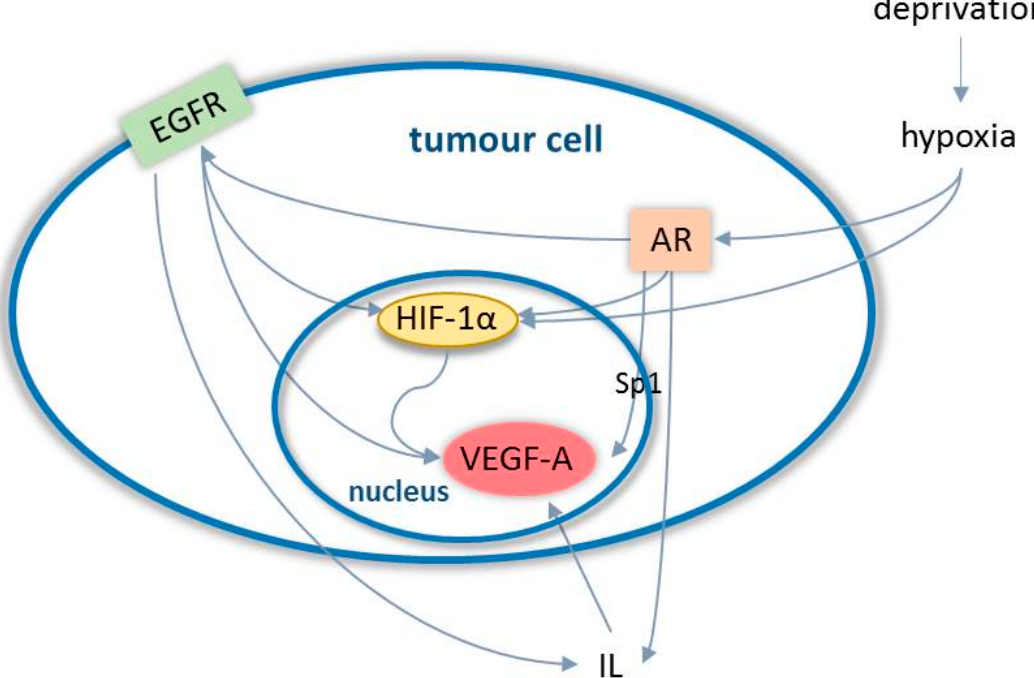
Figure 2. Interaction between angiogenic and androgen receptor pathways in prostate cancer cells. Castration results in androgen depletion which causes hypoxia Hypoxia enhances the transcriptional activity of androgen receptor (AR) at low androgen levels, as seen in castration-resistant prostate cancer. The activated androgen receptor promotes the overexpression of vascular endothelial growth factor A (VEGF-A) through hypoxia-inducable factor 1 α (HIF-1 α ) and (specificity protein 1 (Sp1) related mechanisms and also via regulation of epidermal growth factor receptor (EGFR) expression and upregulation of cytokins, mainly interleukin (IL)-6. [86].